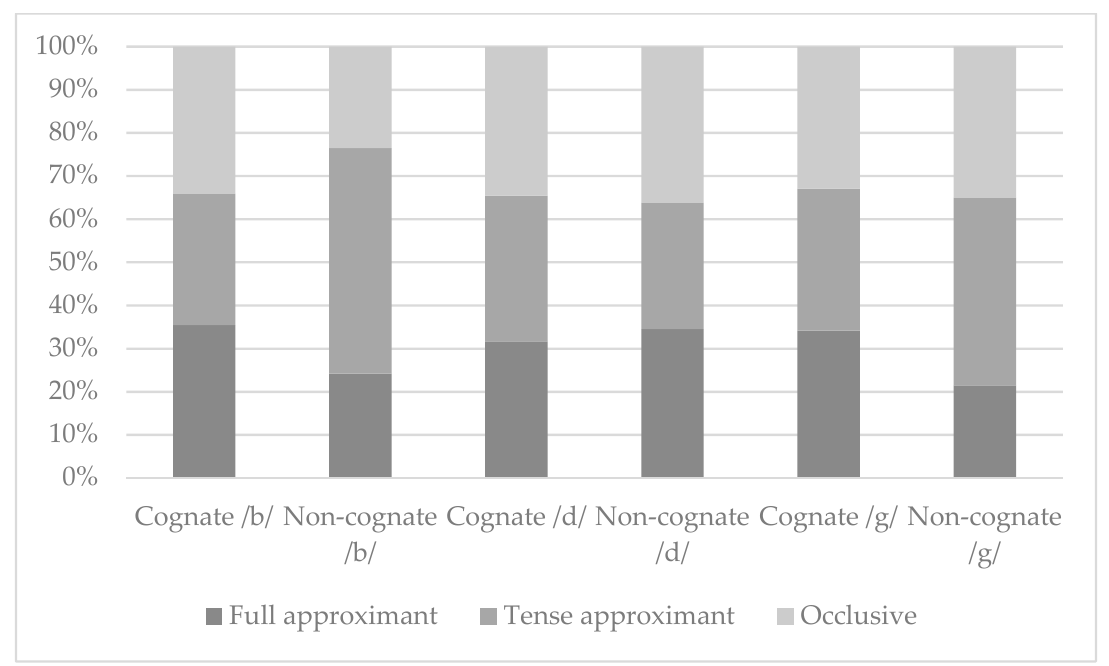
Figure 9. Rates of production types by segment in cognates and non ‐ cognates.